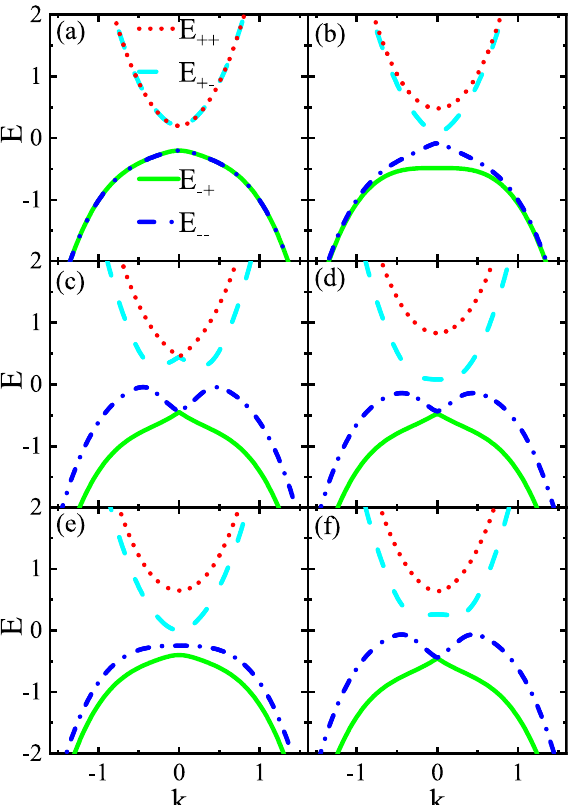
Figure 2. Energy spectra as a function of the k for ( a ) M = 0 and V = 0 , ( b ) M = 0.4 and V = 0 , ( c ) M = 0 and V = 0.4 , ( d ) M = 0.4 and V = 0.4 , ( e ) M > V with M = 0.4 and V = 0.2 , and ( f ) M < V with M = 0.2 and V = 0.4 . Here (cid:31) = 0.2 , s = 1 , and r = 1